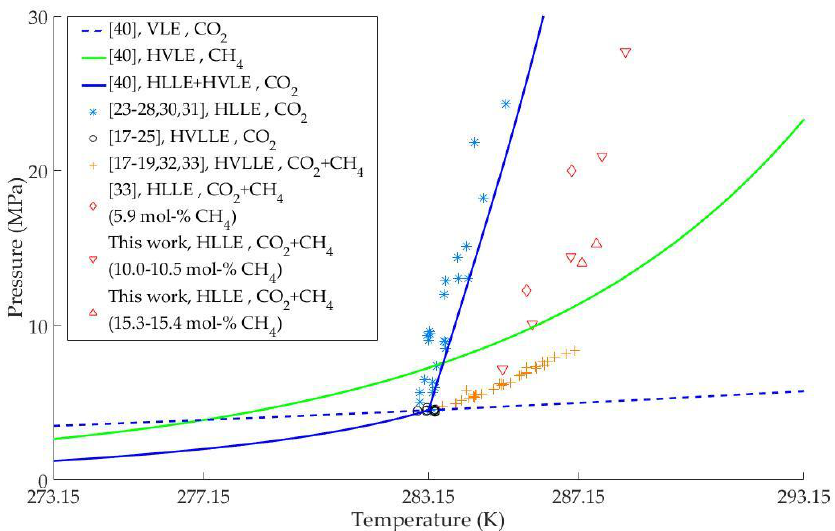
Figure 1. Available experimental data describing gas hydrate equilibria for the (CH 4 )-CO 2 -H 2 O system in the presence of H-L H2O -L CO2 -(V) phases below 30 MPa. HLLE: hydrate-liquid-liquid equilibrium; HVLE: hydrate-vapor-liquid equilibrium; HVLLE: hydrate-vapor-liquid-liquid equilibrium; VLE: vapor-liquid equilibrium.